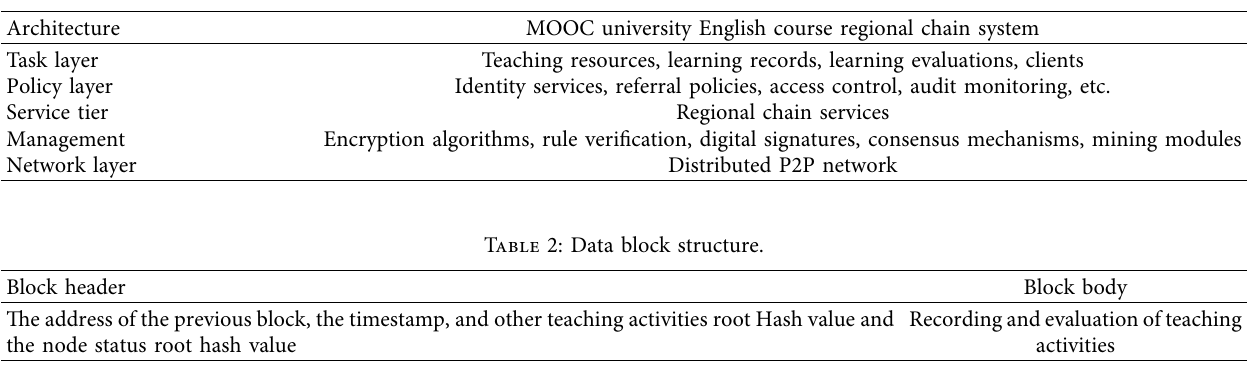
Table 1: Blockchain architecture for MU English courses.